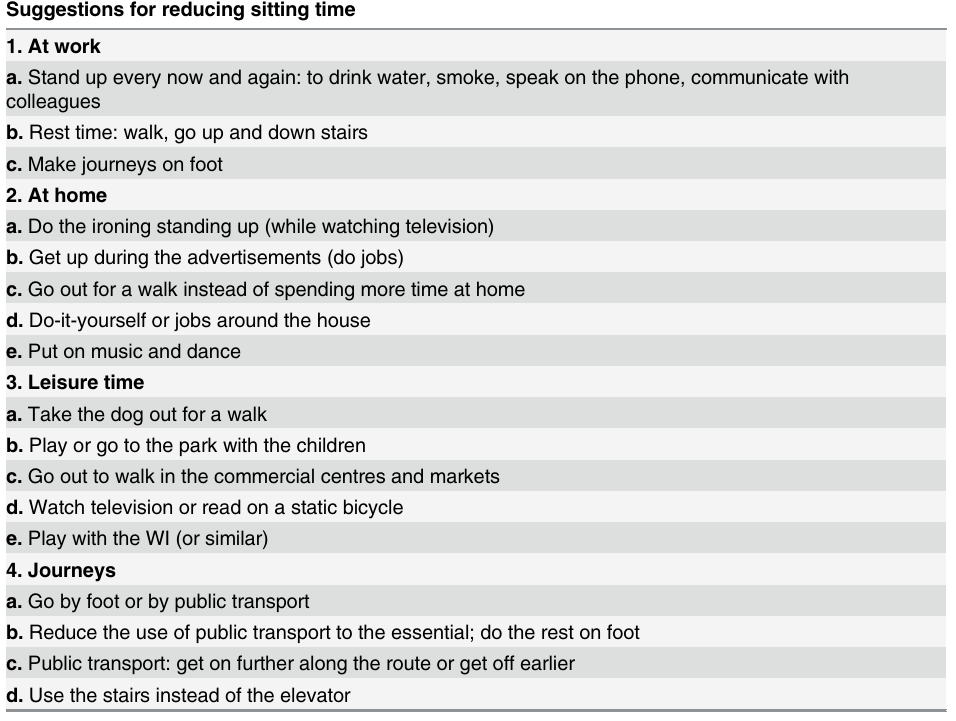
Table 5. Main suggestions for reducing sitting time. Suggestions for reducing sitting